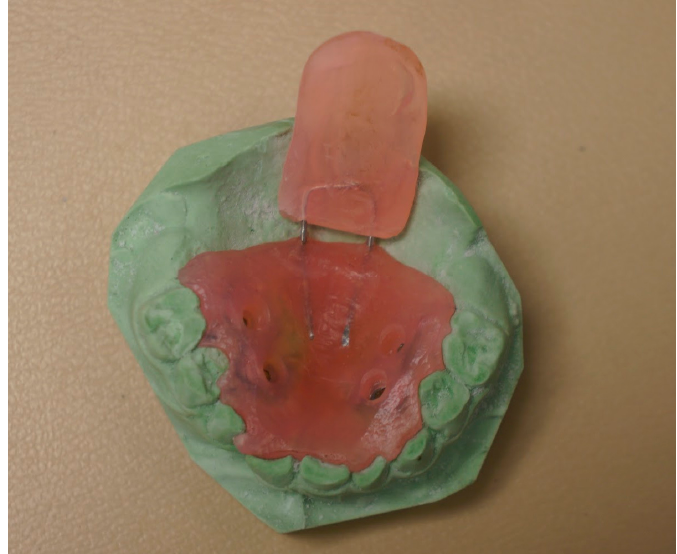
Figure 1. PPS fabricated from a dental impression.